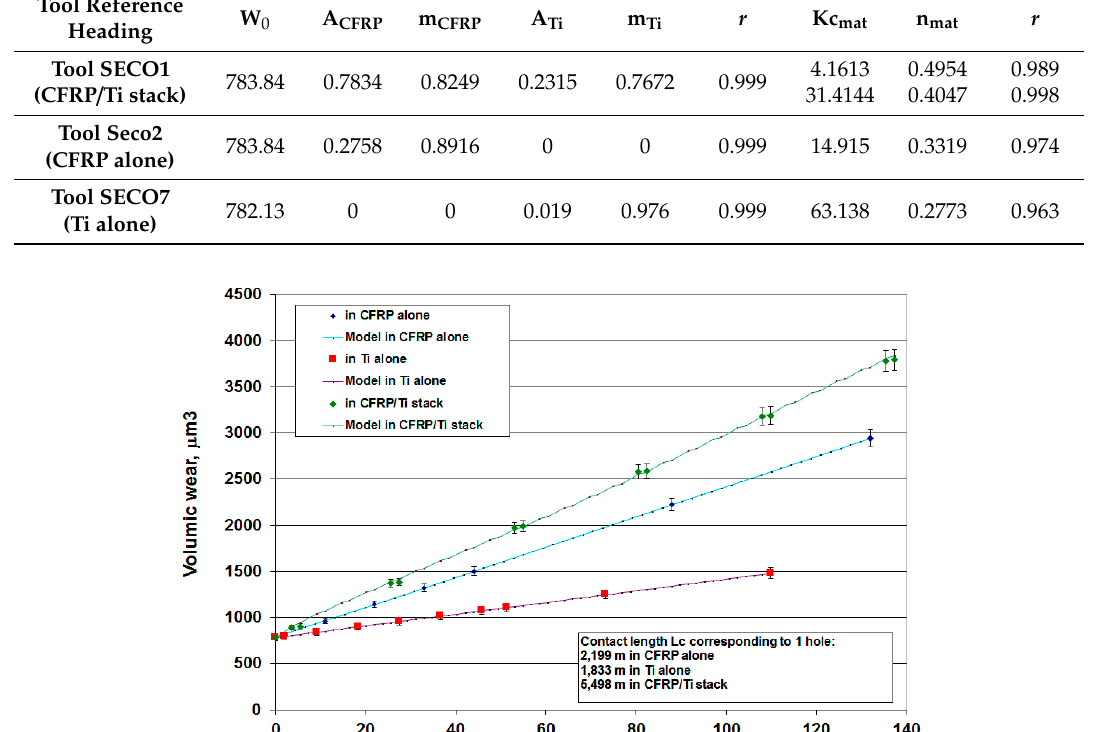
Figure 22. Evolution of tool wear in the different configuration and assuming for CFRP/Ti alloy stacks that 90% of the wear is produced in the CFRP and 10% in the Ti alloy.